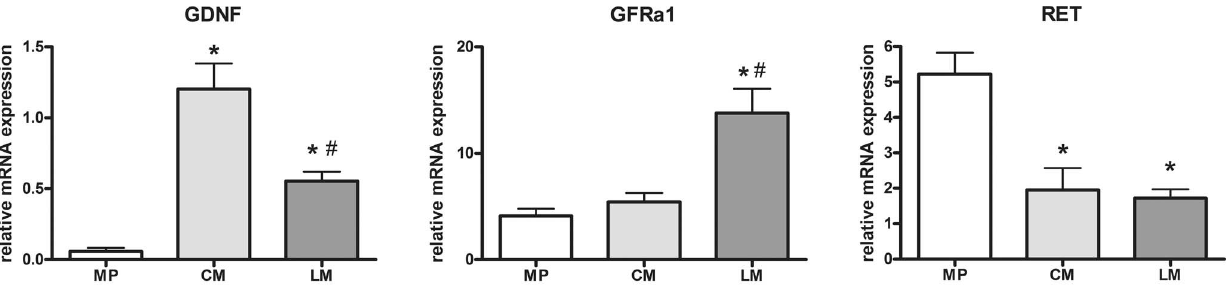
Figure 2. Site-specific mRNA expression of the GDNF system in the human colon. mRNA levels of GDNF (A), GFRa1 (B), and RET (C) in myenteric plexus (MP) and in the circular (CM) and longitudinal (LM) smooth muscle layer isolated by LMD. The main source for GDNF mRNA are the smooth muscle layers, whereas the GFR a 1 is expressed mainly in the longitudinal muscle layer but also in myenteric plexus and RET is predominantly expressed by myenteric plexus and to a lesser extent by smooth muscle layers. mRNA expression levels are normalized to mRNA expression of the house-keeping gene HPRT. Data are shown as mean + / 2 SEM. GDNF: n=10 (MP), n=15 (CM), n=14 (LM), GFRa1: n=10 (MP), n=15 (CM), n=15 (LM), RET: n=10 (MP), n=15 (CM), n=14 (LM). *p , 0.05 vs. MP, # p , 0.05 vs.